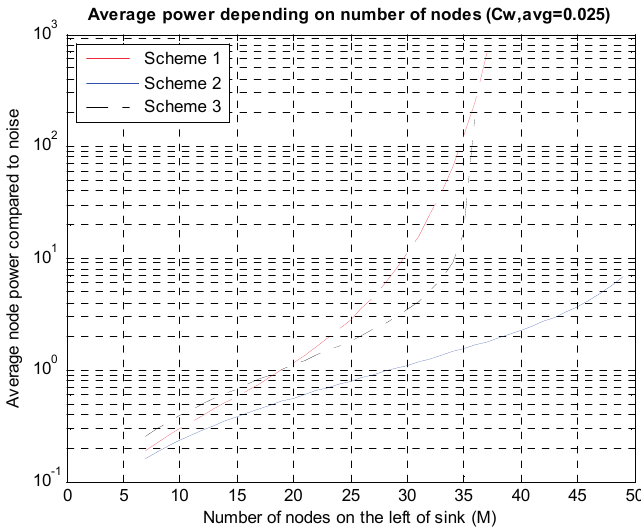
Figure 9. Average power levels according to the numbers of